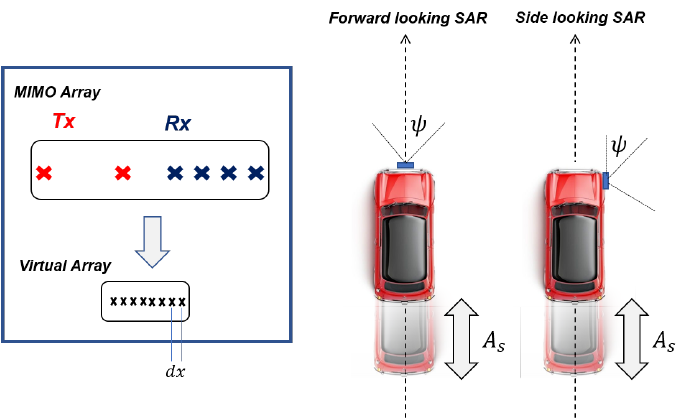
Figure 1. A MIMO radar device transported by vehicle motion over a length A s